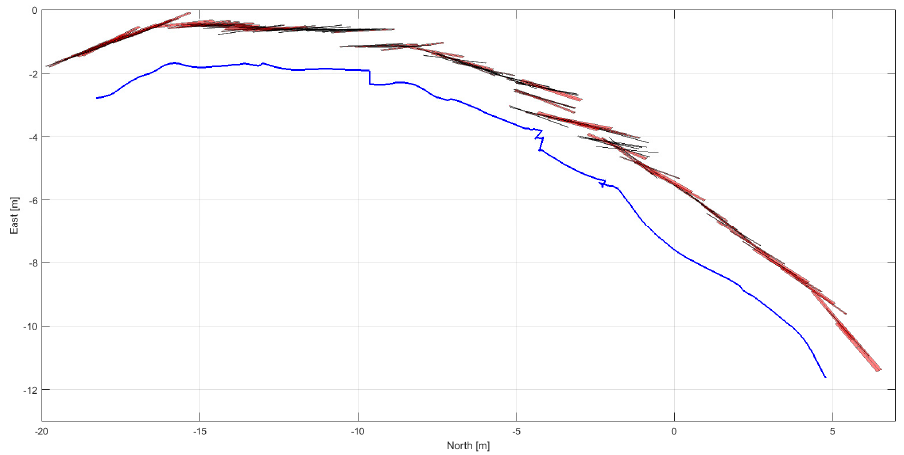
Figure 15. Kalman filter data from leg 3 of the experiment, with the laser measured planes overlaid seen in the North-East plane.